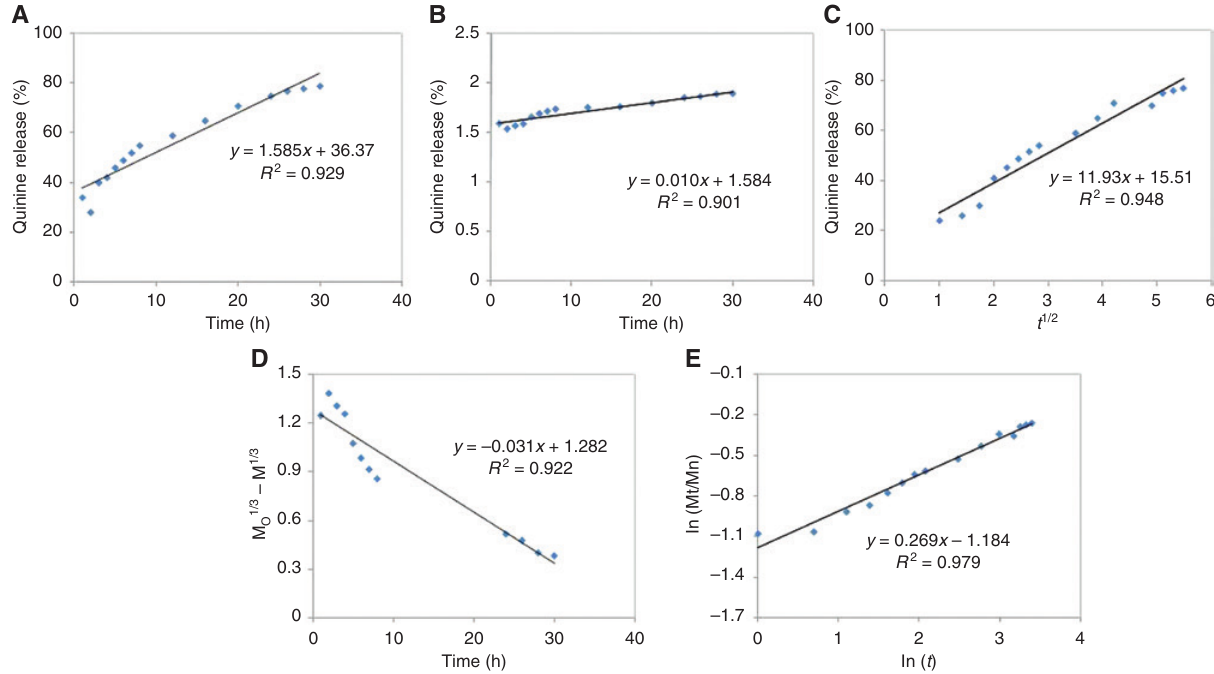
Figure 7: The Hq released kinetic from the PCHq20 nanoparticles in pH 7.4 solution [zero order model (A), first order model (B), Higuchi model (C), Hixson-Crowell model, and (D) Korsmeyer-Peppas model